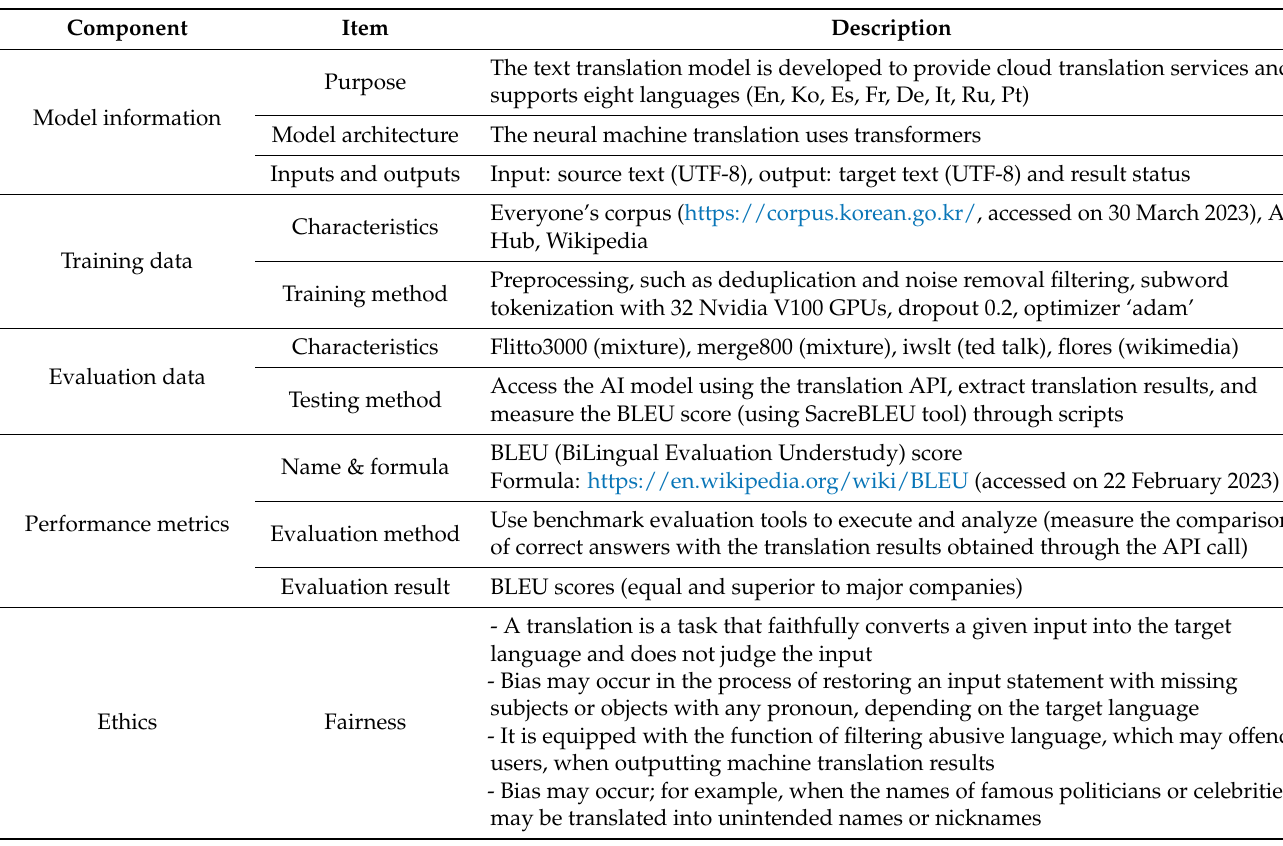
Table 15. Part of the AI model card of the language translation